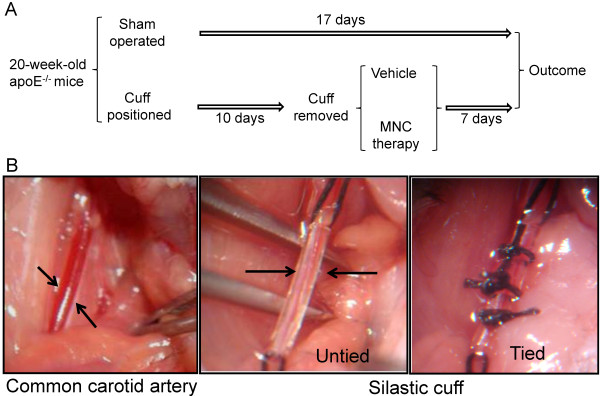
Scheme of the study and carotid artery cuff positioning. Panel A shows the time course of the procedures and treatment of the animals. Panel B presents macroscopic views of an opened neck of an apoE-/- mouse showing, from left to right, a dissected left common carotid artery, a silastic cuff being placed around the artery and the cuff tied around the artery.